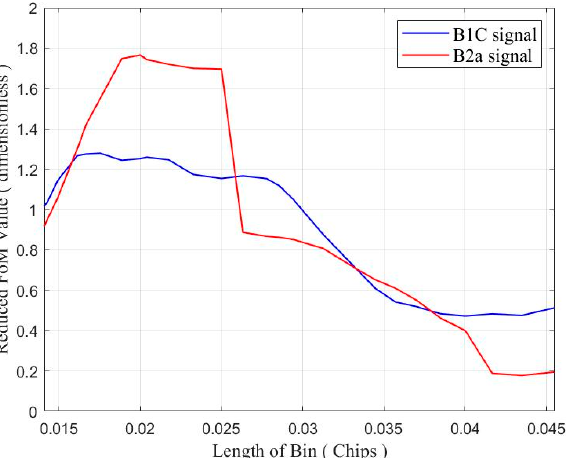
Figure 7. Curves of weighed FoM values after contour reduction, with unequal MERRs.